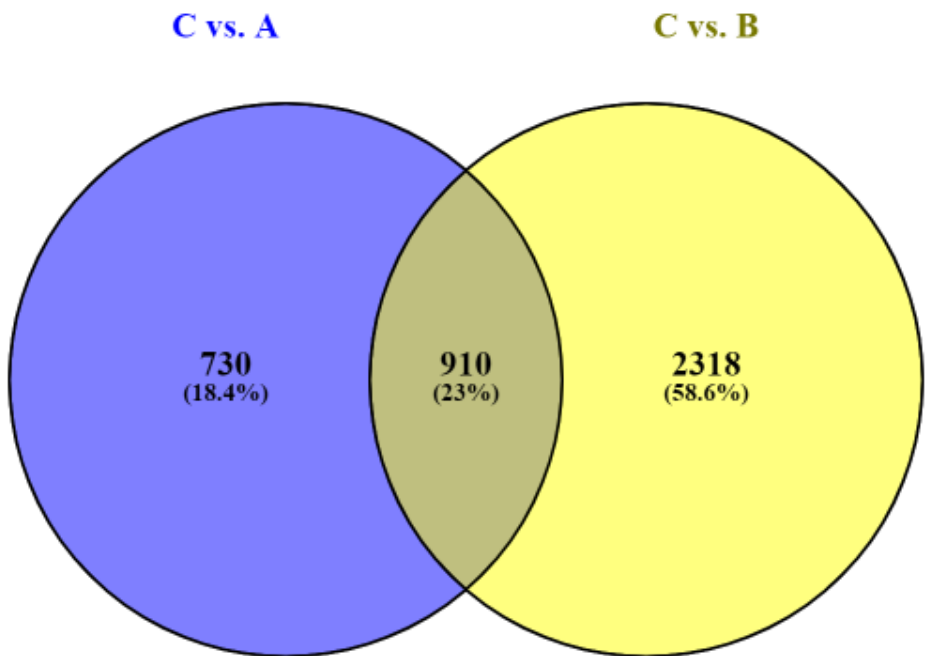
Figure 1. The Venn diagram of common and unique differentially expressed genes (DEGs) following the comparisons of BPV-E4 (A) vs. control (C) groups, and BPV-E1ˆE4 (B) vs. control (C) groups (Venny 2.1 BioinfoGP).